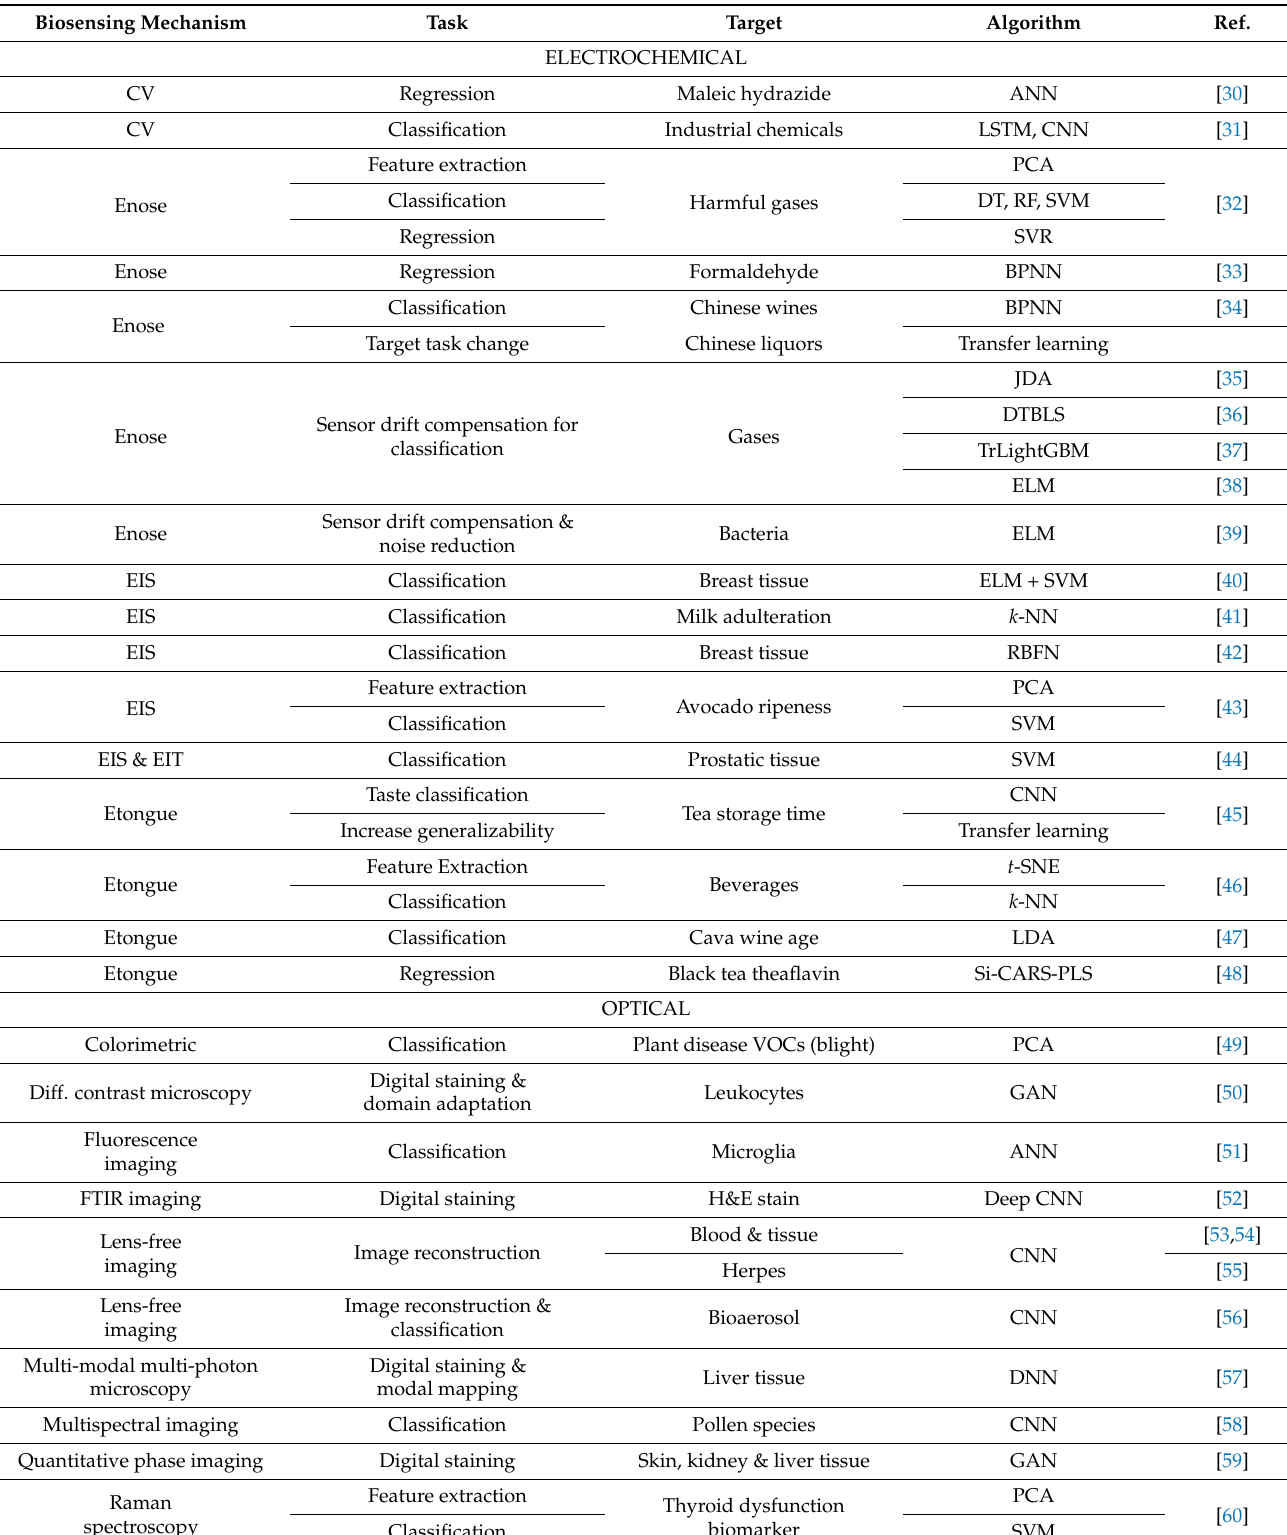
Table 1. Machine learning tasks and algorithms used in